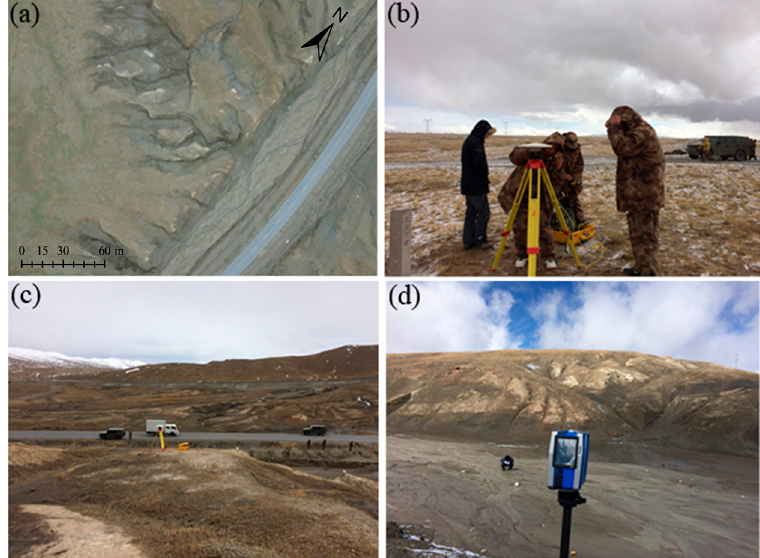
Figure 3. Photographs showing the experiment conducted on the slope in permafrost: ( a ) high angle shot of the slope; ( b ) GNSS datum observation; ( c ) GNSS observation of slope; and ( d ) FARO scanner. GNSS: global navigation satellite system.